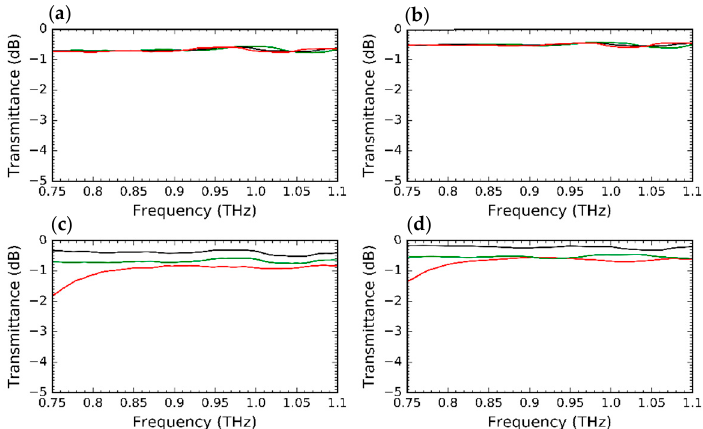
Figure 4. Analysis of the impact of T and W on the performance of 1 cm-long unclad waveguide and EM waveguide: ( a ) Transmittance of unclad waveguide for T = 70 µ m (green), T = 80 µ m (black), T = 90 µ m (red) and W is fixed at 100 µ m; ( b ) Transmittance of EM waveguide for variable T with fixed W = 100 μ m; ( c ) Transmittance of unclad waveguide for W = 80 μ m (red), W = 90 μ m (green), W = 100 μ m (black) and T is fixed at 80 μ m; ( d ) Transmittance of EM waveguide for variable W with fixed T = 80 μ m.